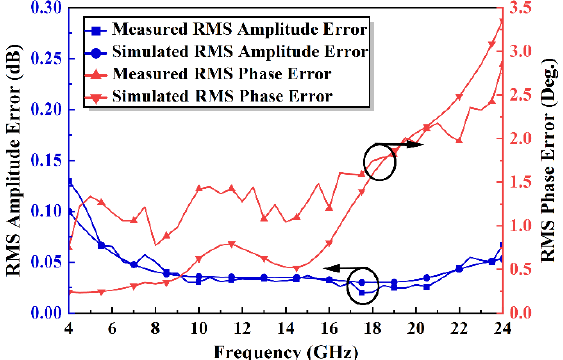
Figure 21. The simulated and measured amplitude error RMS and relative phase error RMS.